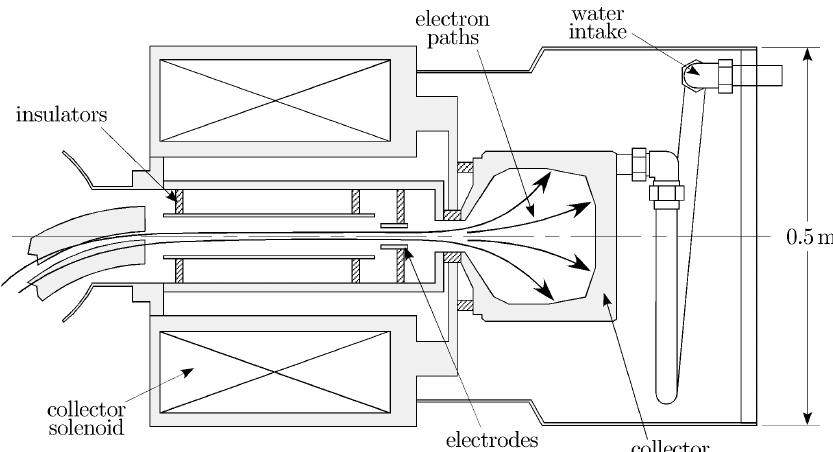
FIG. 14. Scaled sketch of the collector cross section. The collector itself is a water-cooled copper cavity that resides outside the solenoid. This allows the electron beam to spread out, distributing the heat load and decreasing the production of secondary